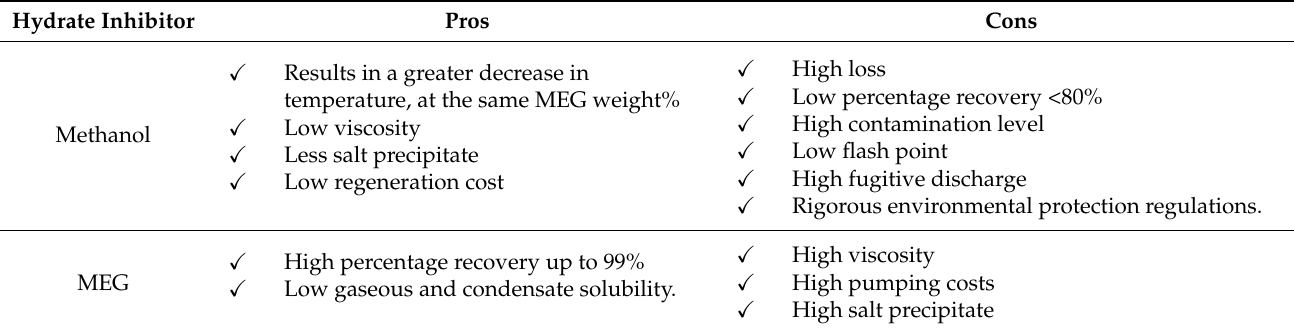
Figure 5. Three-dimensional structures of the main alcohols used as THIs (methanol, monoethylene glycol, and diethylene glycol). Table 1. Comparison between methanol and MEG based on hydrate